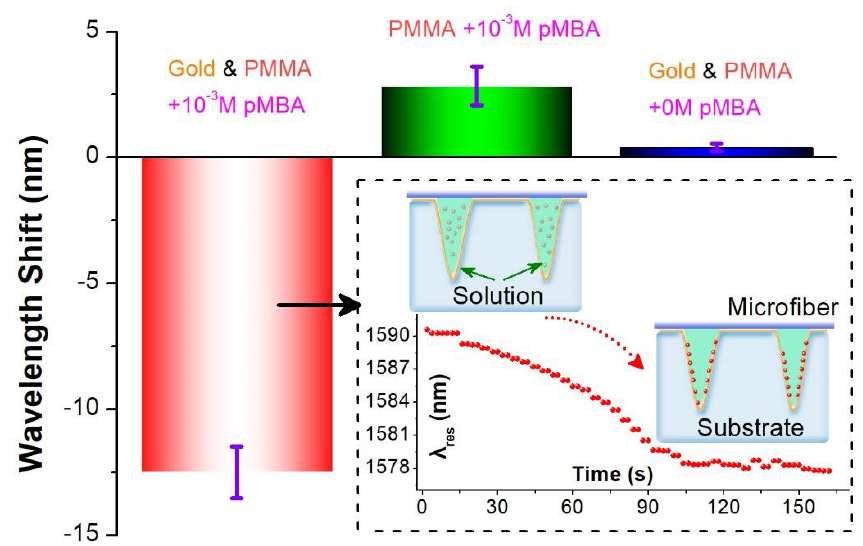
Figure 3. Response of the VIOLIN sensors for targeting pMBA solutions. Inset: the diagram and dynamic process of pMBA sensing using the gilded-VIOLIN.